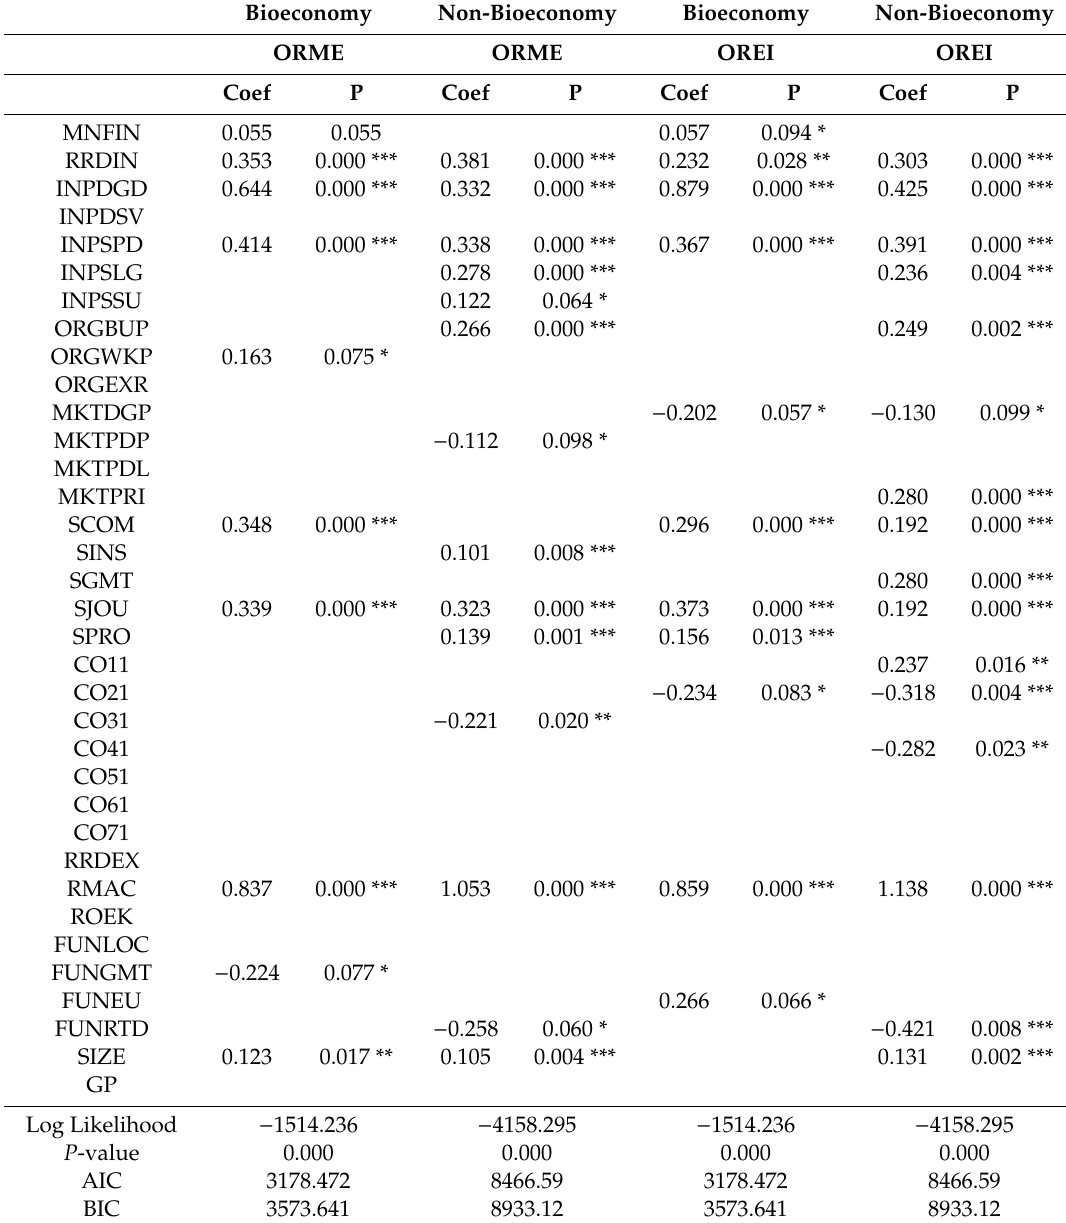
Table A8. Estimation results of multivariate tobit model Czech